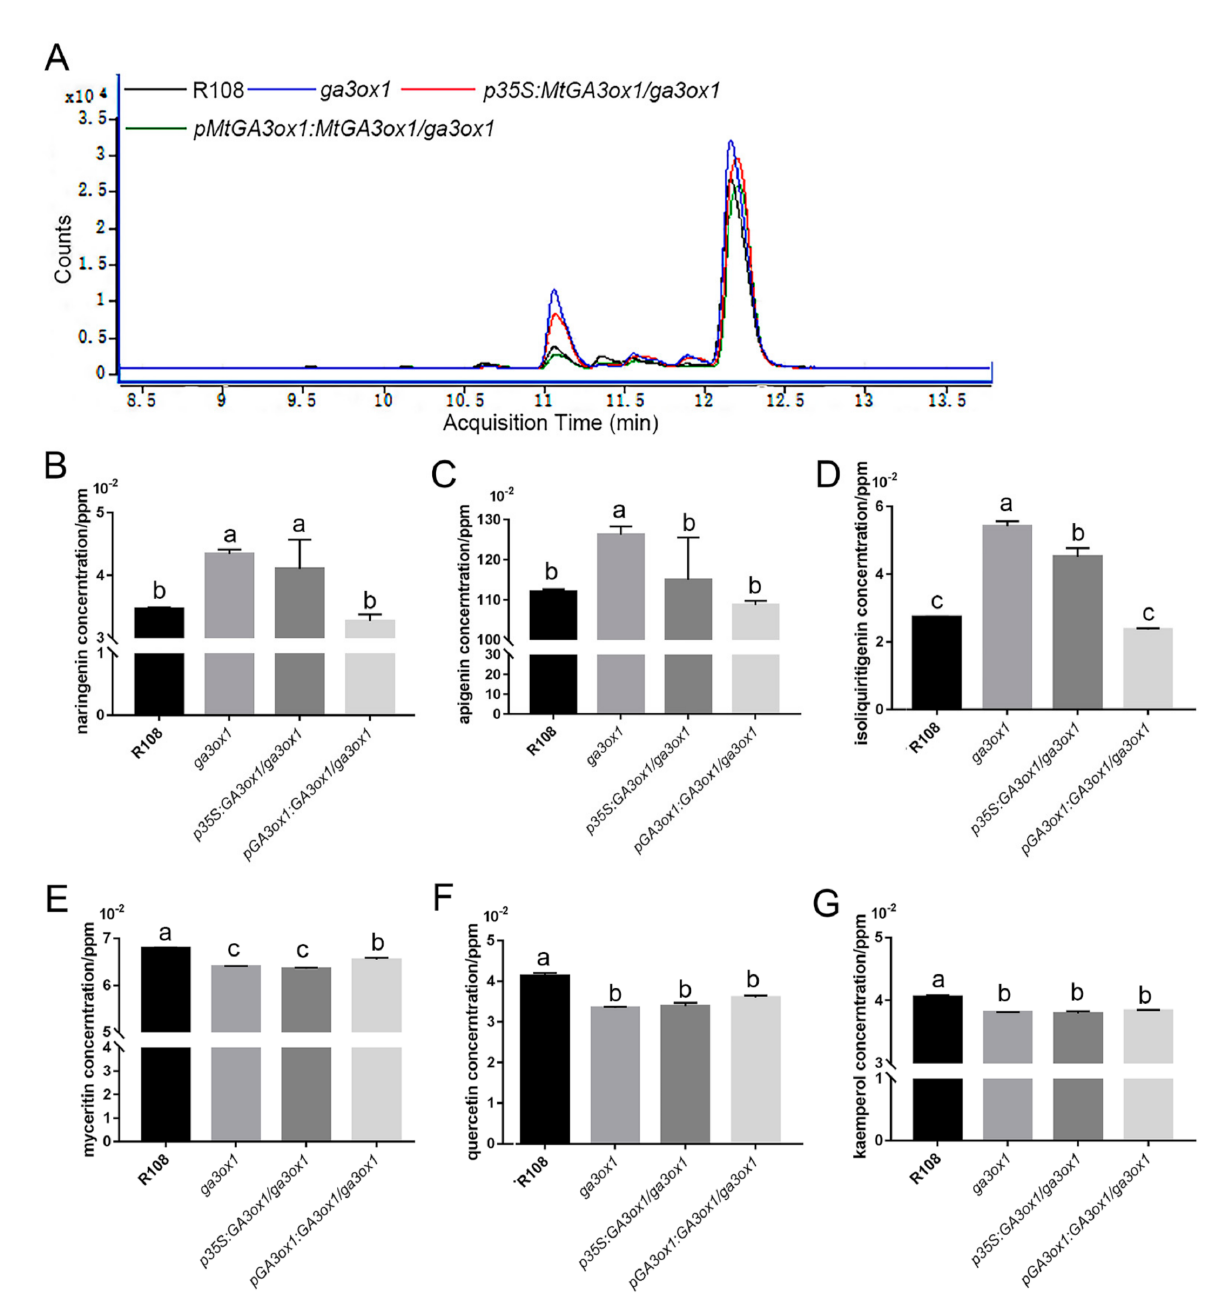
Figure 7. HPLC chromatograms and absorbance spectra of flavonoid extracts from leaves. ( A ) Chromatograms of leaf extracts from 1-month-old wild-type R108 (black line), ga3ox1 mutant (blue line) and p35S:MtGA3ox1/ga3ox1 (red line), pMtGA3ox1: MtGA3ox1/ga3ox1 (green line) leaves. ( B – G ) The absolute content of naringenin, apigenin, isoliquiritigenin, myc- eritin, quercetin and kaemferol were determined based on the HPLC-MS analysis. Three biological replicates were analyzed, and error bars denote the SD. Different letters above the bars indicate significant difference ( p < 0.05 by Duncan